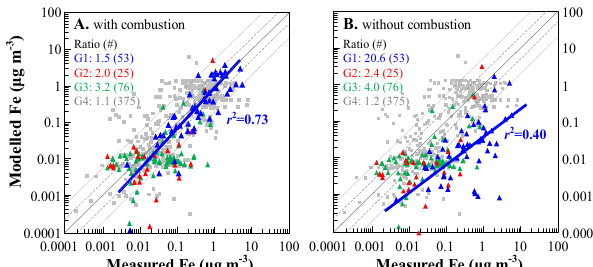
Figure 12. Plots of modelled and measured Fe concentrations at- tached to aerosols in surface air with (a) or without (b) combus- tion sources. All stations were divided into four groups based on the contribution of combustion sources: G1, contribution ≥ 50% (blue triangles); G2, 30% ≤ contribution<50% (red triangles); G3: 15% ≤ contribution<30% (green triangles); G4, contribu- tion<15% (grey squares). The ratios between measured and mod- elled concentrations as geometric means are listed with the number of stations in parentheses for each group. The fitted curves for the G1 stations are shown as blue lines with coefficients of determina- tion ( r 2 ) .